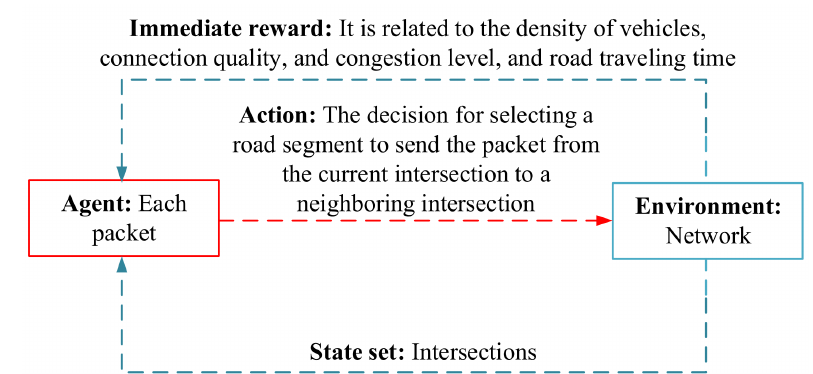
Figure 25. Learning structure in